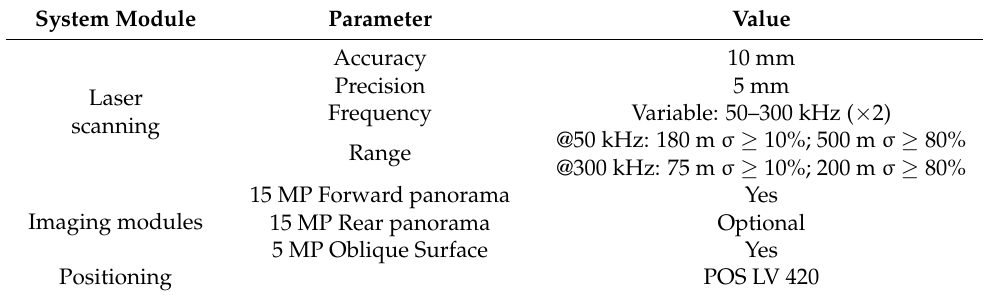
Table 1. Technical specification of Trimble MX8 Land Mobile Mapping System.